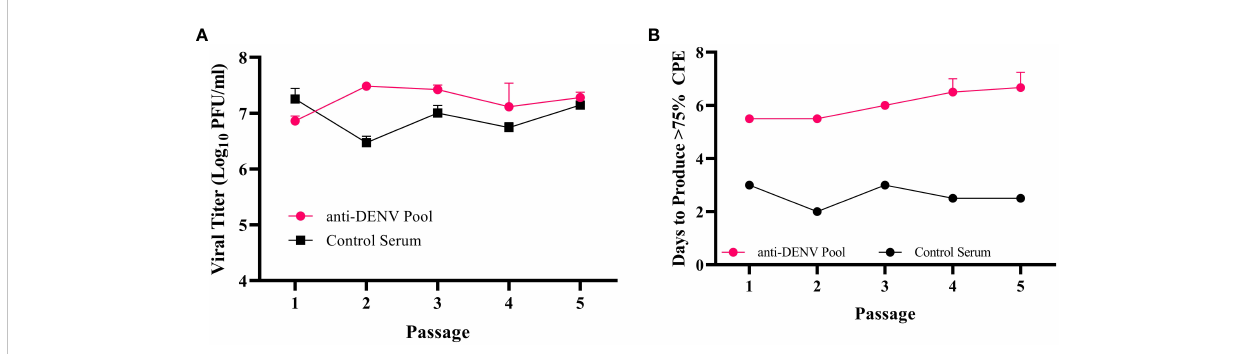
FIGURE 1 Zika virus (ZIKV) passaging work fl ow. (A) The post-passage titers of the anti-DENV pool and control serum passaged virus, as measured by plaque assay. Data represent the three independent lineages within each passaging condition (anti-dengue virus (DENV) Pool or Control Serum) (B) During passaging, viral supernatant was harvested when >75% of cells demonstrated cytopathic effects (CPE). The days post-infection where this occurred were recorded for each passage. Data represent the three independent lineages within each passaging condition (anti-dengue virus (DENV) Pool or Control